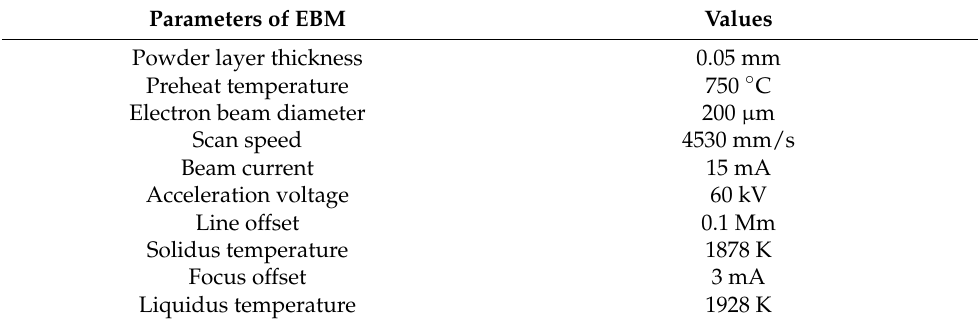
Table 2. Parameters for EBM processing of Ti6Al4V components [33,34].